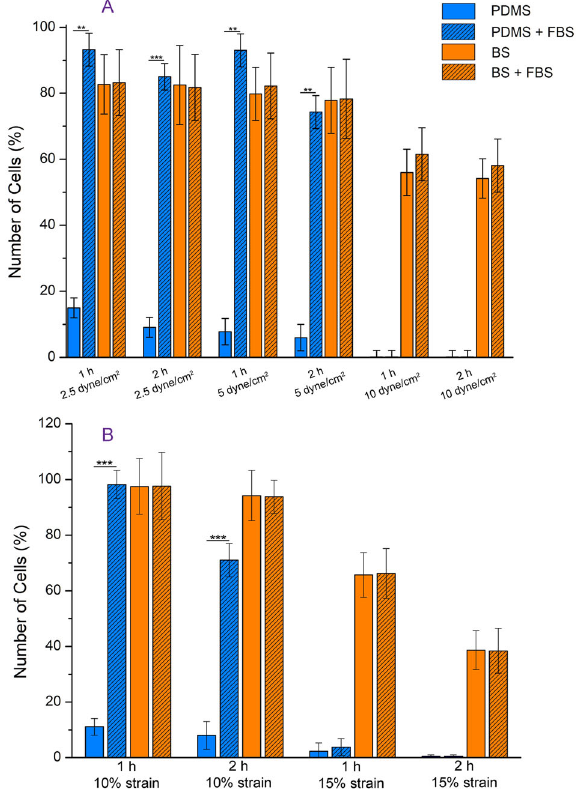
Fig. 4 Cell adhesion assay. Percent of remaining cells on the scaffold after exerting cyclic shear stress ( A ) and stretch ( B ) to the scaffold were calculated. The blue column is PDMS and the orange ones BS. FBS treatment was used to improve cell adhesion. ** p < 0.01, *** p <